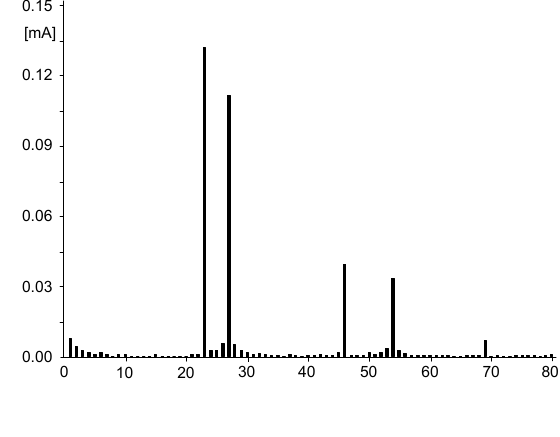
Figure 13. DC line voltage spectrum (two parallel DC/DC boost